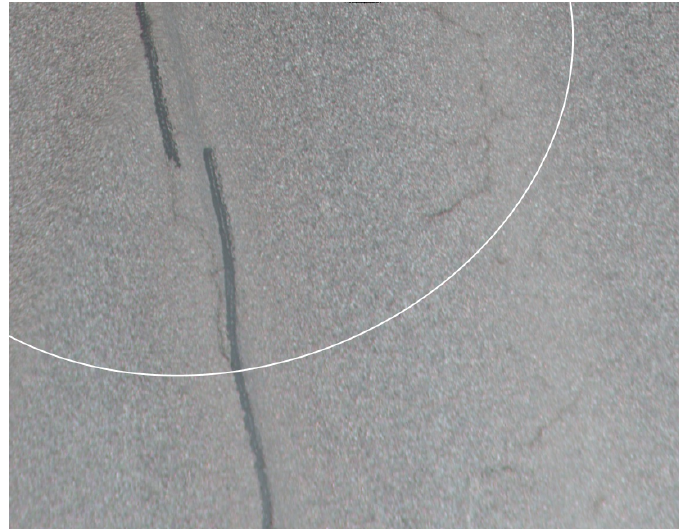
Figure 2. Gradual loss of detail when the distance from the camera increases. The area above the white circle is considerably sharper than the rest of the image.